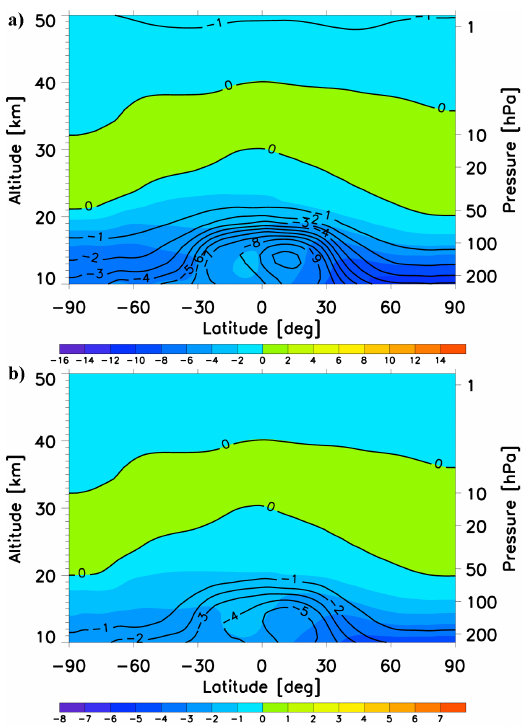
Figure 3. Annually, zonally averaged O 3 concentration changes in units of 10 10 molecules cm - 3 (shown by color) and the relative change in % (shown by contours) in the H 2 -FC scenarios compared with the BL scenarios as a function of latitude and altitude for (a) A1FI and (b) B1 scenarios.